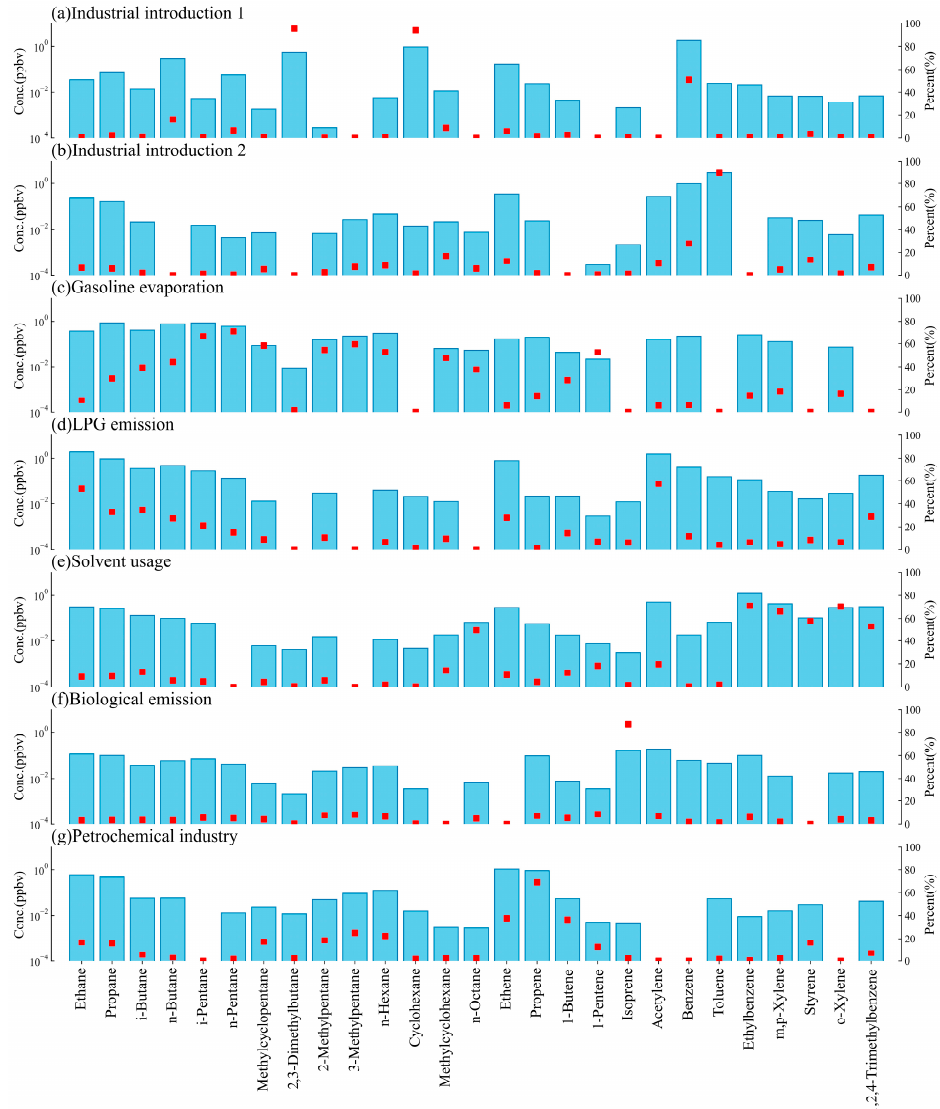
Figure 4. The source profiles (blue bars) and distributions of each species for the different factors (red squares) in the autumn. ( a ) Industrial introduction 1; ( b ) Industrial introduction 2; ( c ) Gasoline evaporation; ( d ) LPG emission; ( e ) Solvent usage; ( f ) Biological emission; ( g ) Petrochemical indus- try.